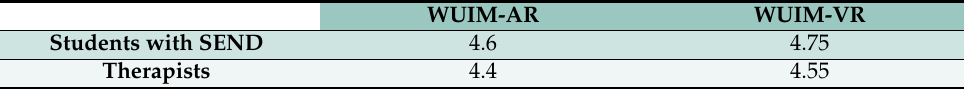
Table 6. User evaluation comparison between WUIM-AR and